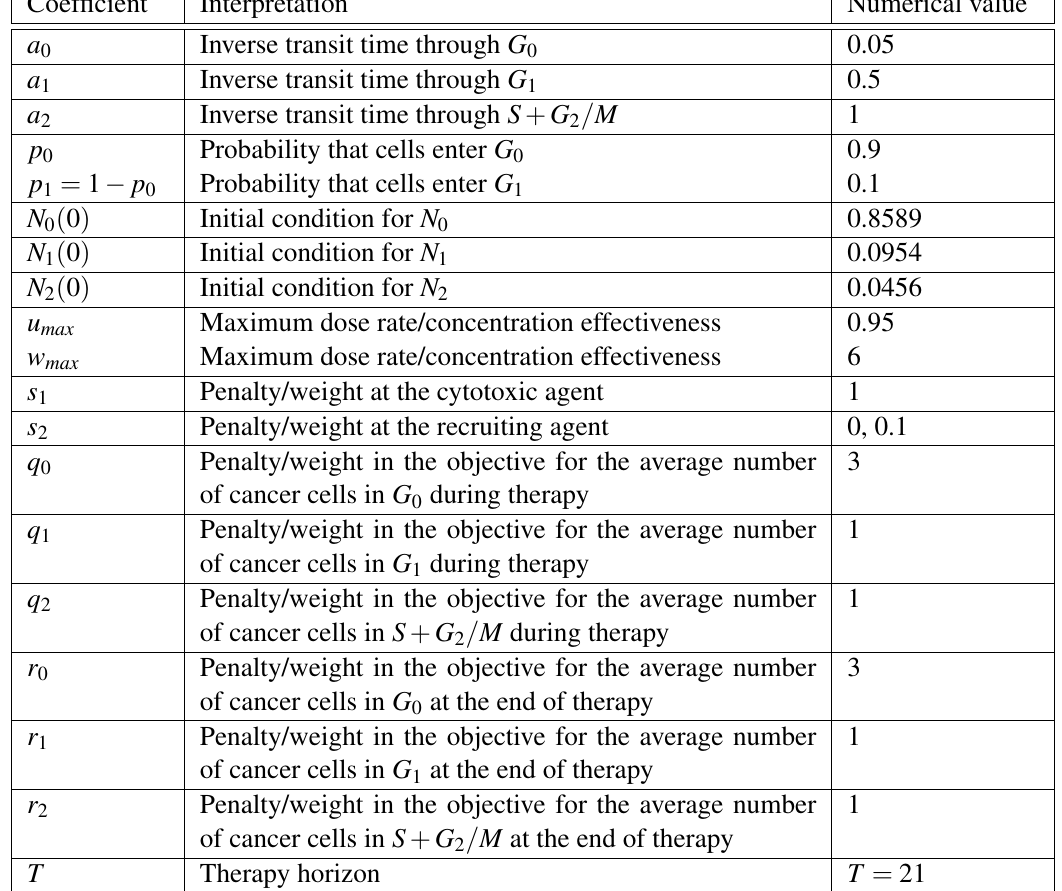
Table 2 Numerical values for the coefficients and parameters used in numerical computations for the optimal control problem 2 with cytotoxic and recruitment agents, extracted from